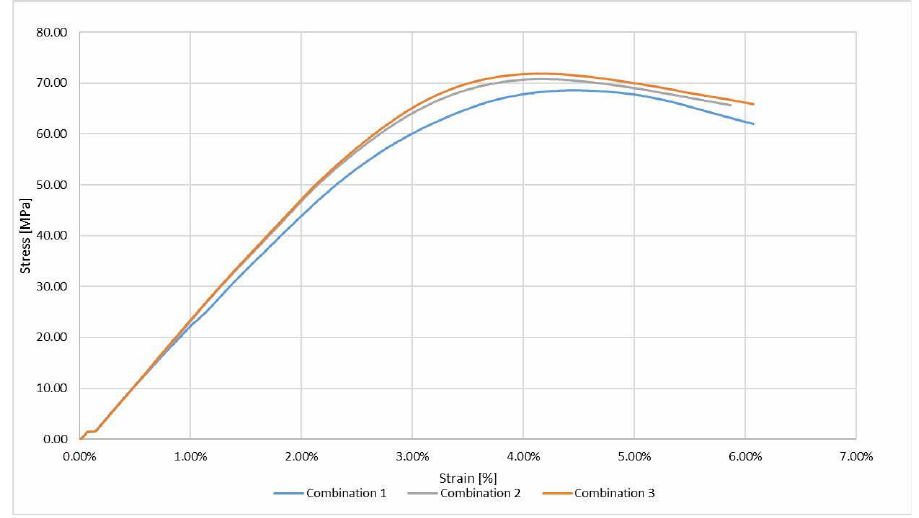
Figure 12 . Optimum combinations of flexural strength.